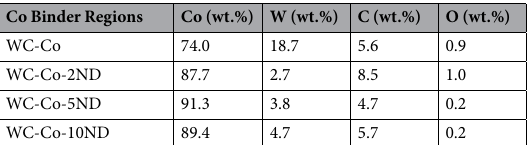
Table 5. EDS point analysis of Co binder region in SPS consolidated